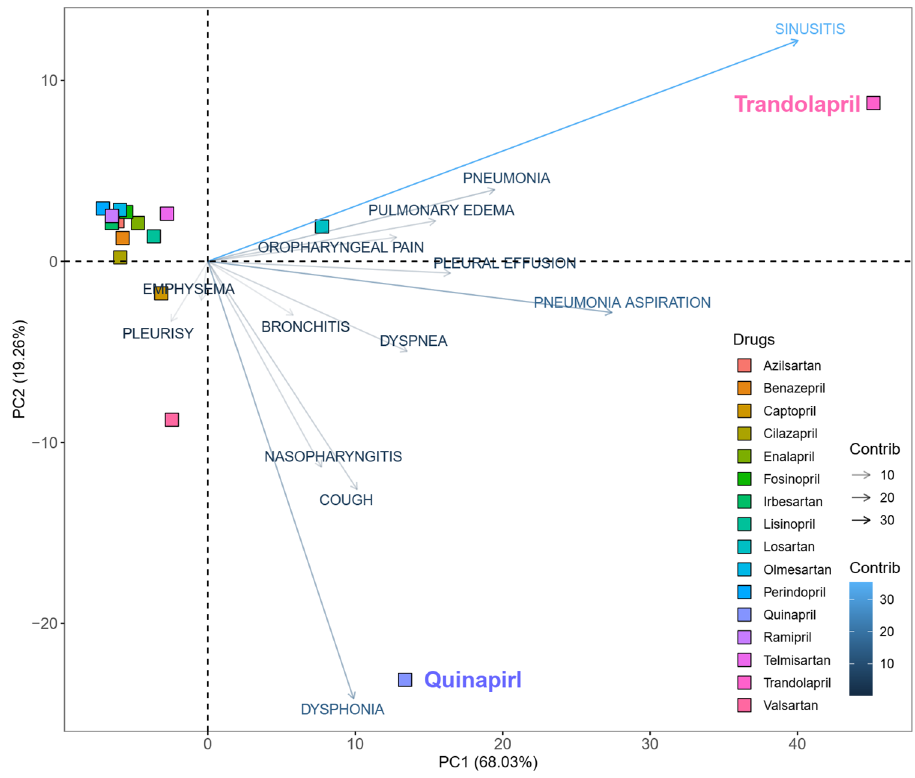
Figure 2. Principal component analysis of proportional report ratios for ACEIs and